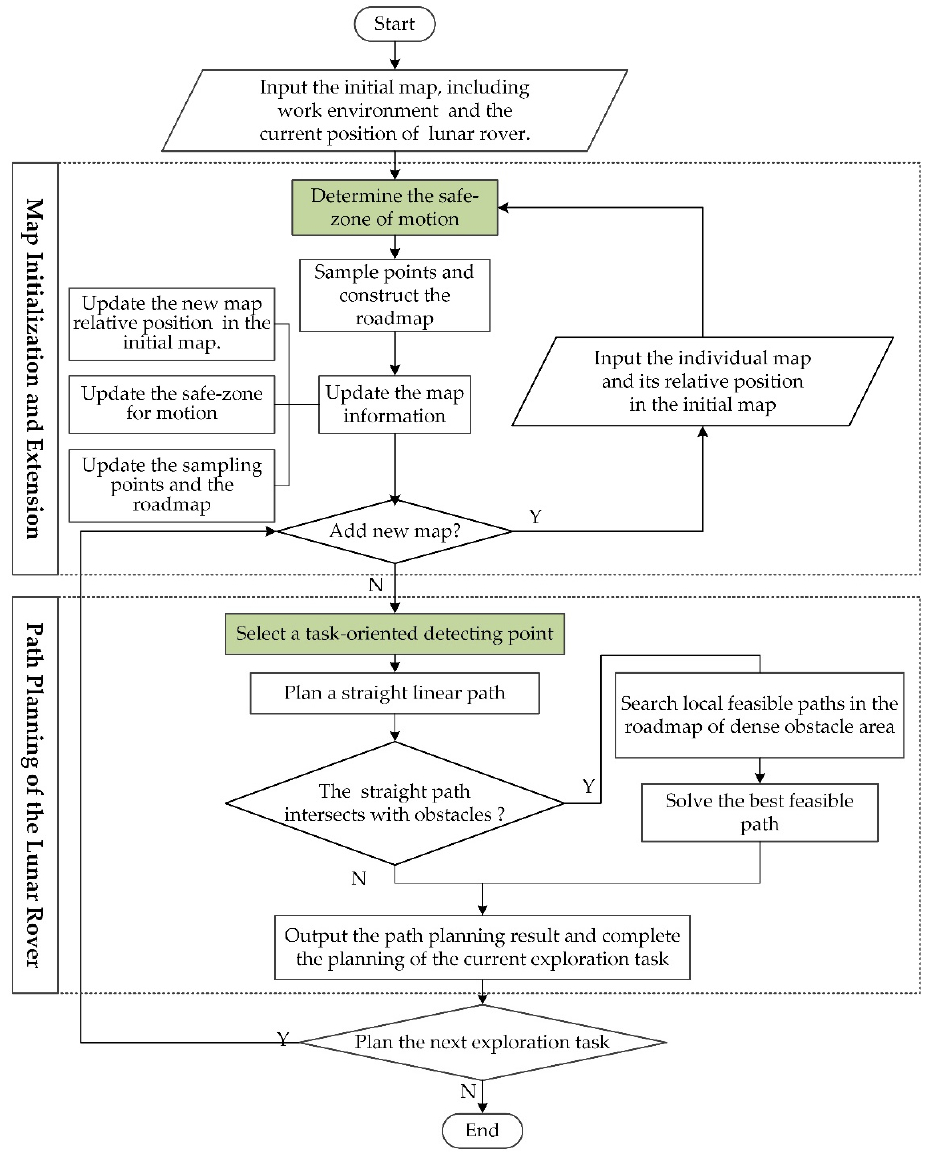
Figure 15. The flow of path planning with map extension.